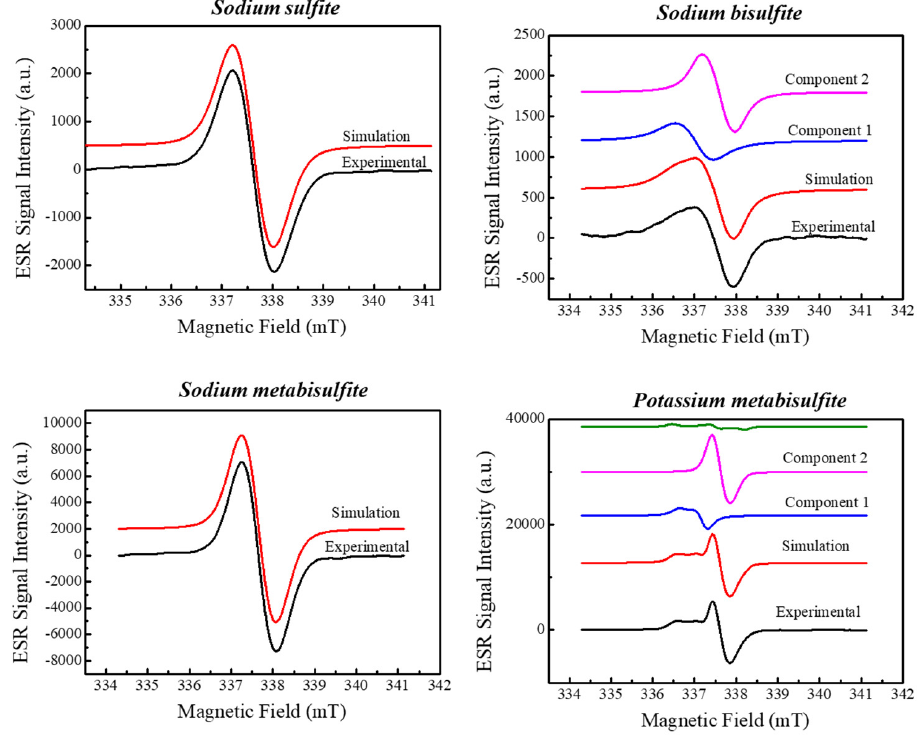
Figure 2. Simulation of ESR spectra of sulfites irradiated with 500 Gy. Table 1. Parameters of Spin Hamiltonian of sulfites, g-factor and linewidth (LW). Compound